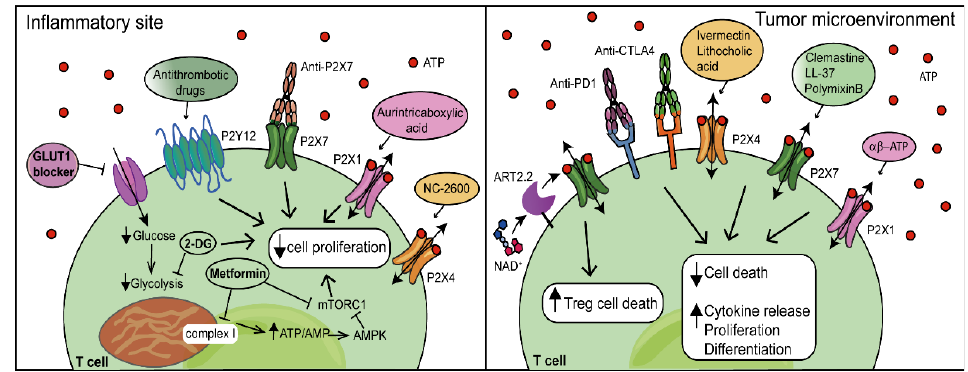
Figure 3. Targeting cell metabolism and P2 receptors to modulate T-cell activation and differentiation. Metabolic inhibitors such as 2-deoxyglucose (2DG), metformin or glucose transporter (GLUT) 1 blockers inhibit T-cell responses and reduce proliferation, providing potentially useful targets for the treatment of inflammatory and autoimmune diseases. On the contrary, improving T-cell metabolism and activation by inhibiting programmed cell death (PD)-1 or cytotoxic lymphocyte antigen (CTLA) 4 receptors is a current cancer treatment option. In addition, P2 receptors are emerging as useful targets to inhibit or enhance T-cell metabolism and effector functions at inflammatory sites or in the tumour microenvironment, respectively. 2-DG, 2-deoxyglucose; mTORC1, mammalian target of rapamycin complex 1; AMPK, AMP-activated protein kinase; ART2.2, ADP-ribosyltransferase 2.2. In addition to metabolites and metabolic enzymes [for example, phosphoenolpy-